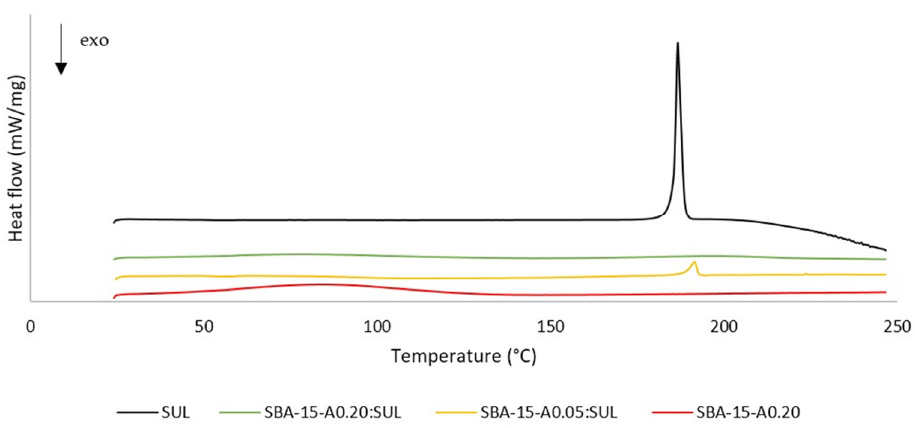
Figure 2. DSC thermograms of SUL, SBA ‐ 15 ‐ A 0.05 :SUL, SBA ‐ 15 ‐ A 0.20 :SUL, and SBA ‐ 15 ‐ A 0.20